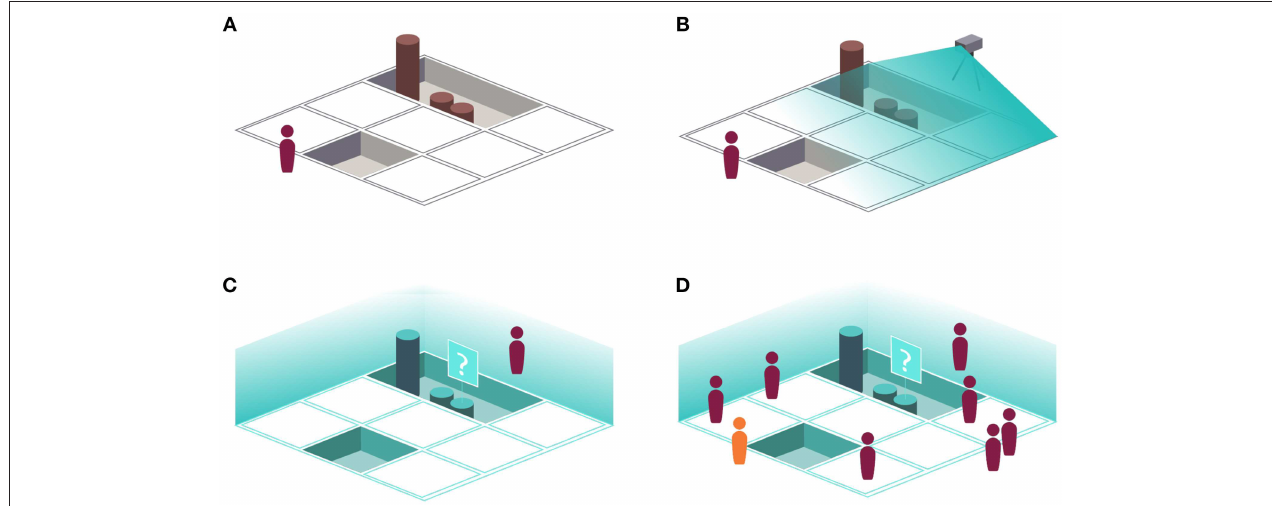
FIGURE 9 | (A) Conventional archaeological fieldwork, with an archaeologist physically present at the excavation site. (B) Conventional fieldwork, with the addition of 3D scanning (LIDAR, photogrammetry, etc.) to document the ongoing excavation. (C) An archaeologist viewing an immersive virtual reconstruction of the excavation at a particular stage, made possible via the 3D scanning illustrated in (B) . Note that the system is presenting additional information about a particular artifact, possibly including high-resolution photographs, 3D scans, field notes, corroborating evidence from the Internet, etc. (D) Immersive archaeology applied to an educational